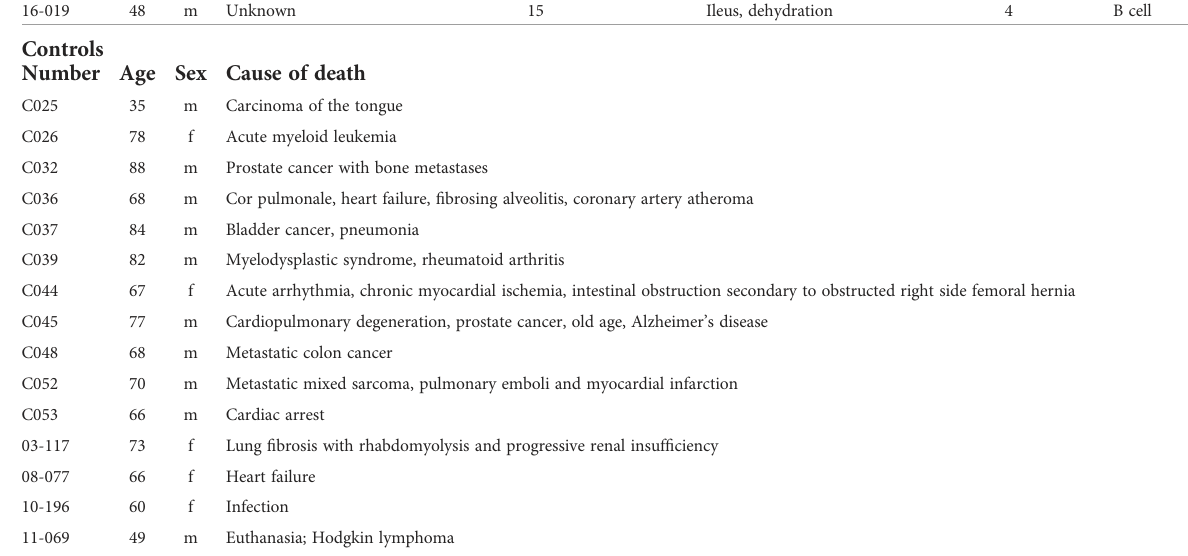
m Euthanasia; Hodgkin lymphoma f, female; m, male; NI, no CD3/ CD20 in fi